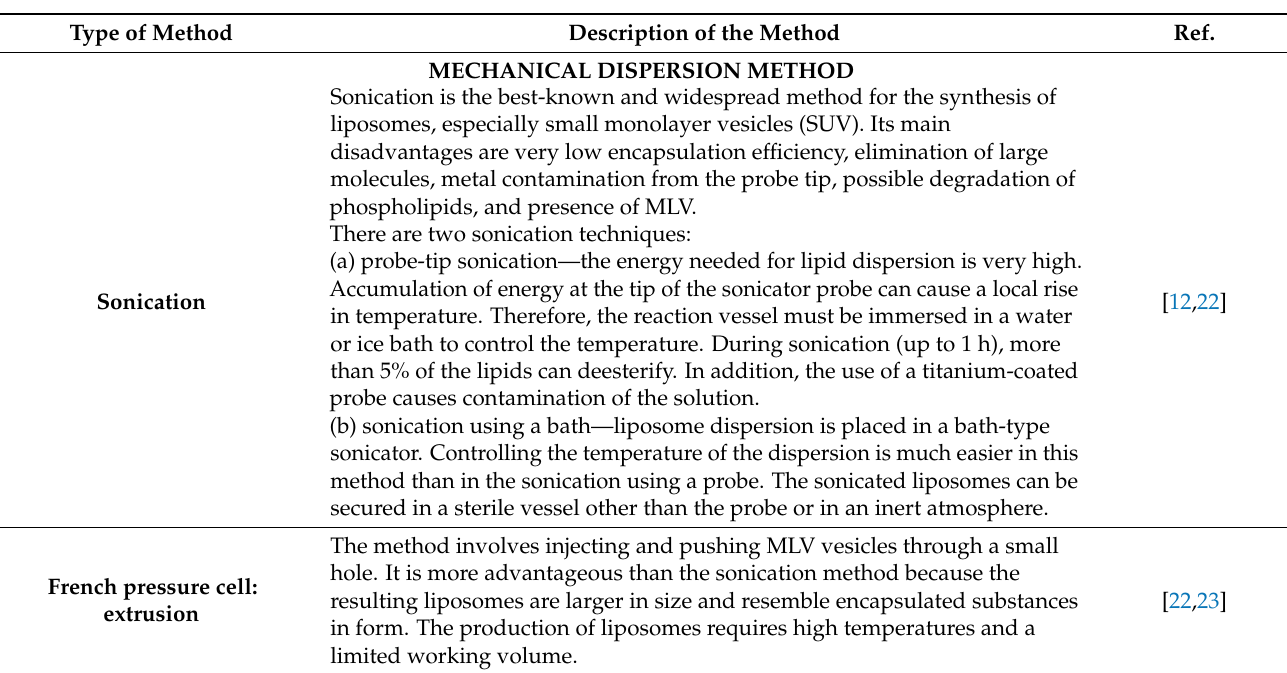
Table 1. The most common methods for producing liposomes. Description of the Method